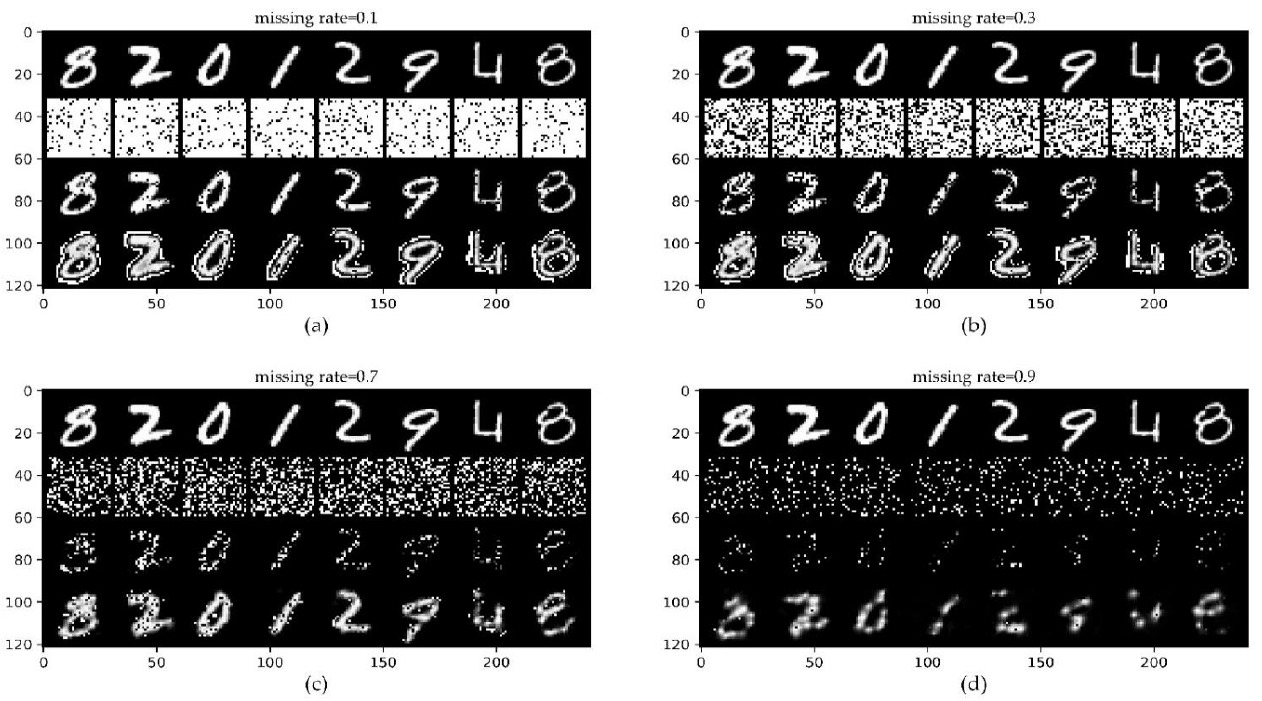
Figure 7. ConvCNPs-Net for MNIST with MR. ( a – d ) show that the missing rate takes values from [0.1, 0.3, 0.7, 0.9], respectively, to test the performance of the trained ConvCNPs-Net and ConvCNPs–SDE models. For each panel, the top row shows the original ID data MNIST, the second row demonstrates the mask based on MR, the third row exhibits the ID MNIST data with the mask, and the bottom row displays how the masked MNIST data are completed by the ConvCNPs of the ConvCNP – SDE model.